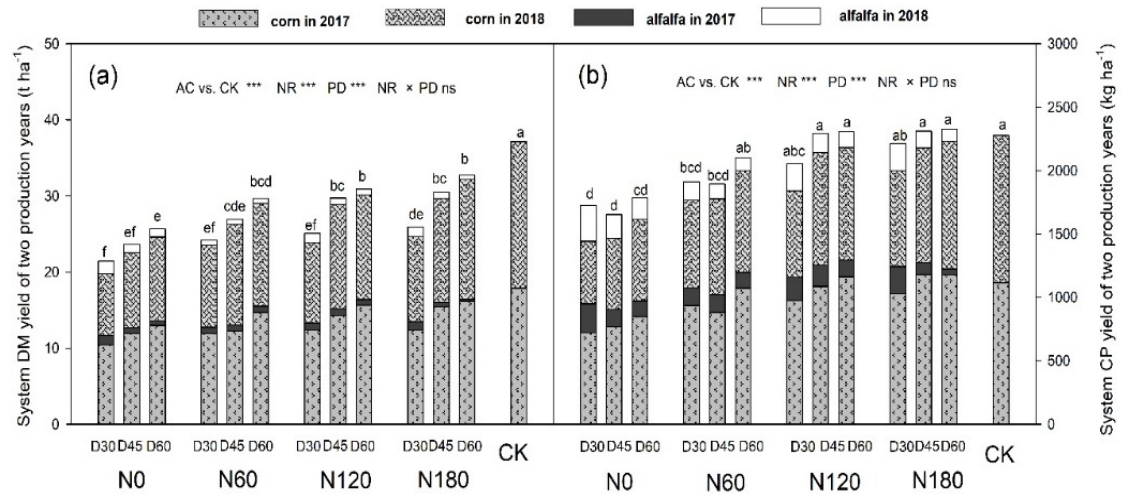
Figure 2. System total dry matter (DM) yield ( a ) and crude protein (CP) yield ( b ) of alfalfa–silage corn relay intercropping (AC) and silage corn monoculture control (CK) as affected by nitrogen application rate (NR) and corn plant density (PD). N0, N60, N120 and N180 mean N application rate of 0, 60, 120 and 180 kg N ha − 1 . D30, D45 and D60 mean corn seeding rate of 30, 45 and 60 thousand plants ha − 1 . Different letters indicate significant differences at the level of p < 0.05. *** indicates significant difference at p < 0.001; ns indicates not significant at p < 0.05. Table 2. Forage dry matter (DM) yield, crude protein (CP) content, CP yield of alfalfa–silage corn relay intercropping (AC) and silage corn monoculture control (CK) as affected by nitrogen appli- cation rate (NR) and corn plant density (PD).